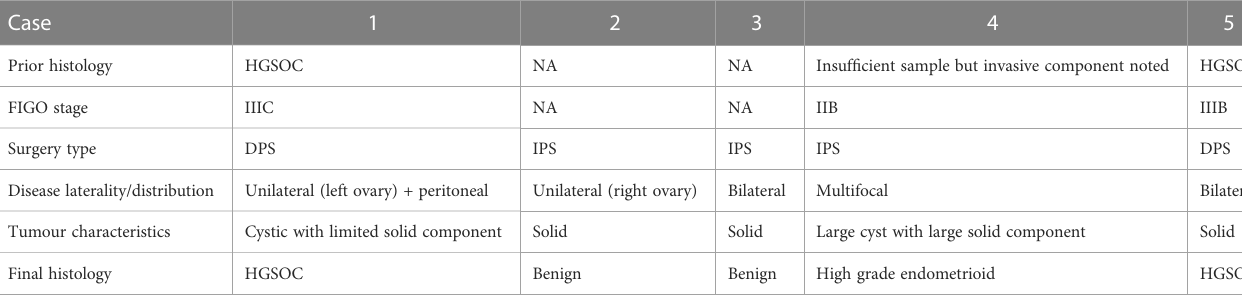
TABLE 1 Clinical characteristics of the pilot